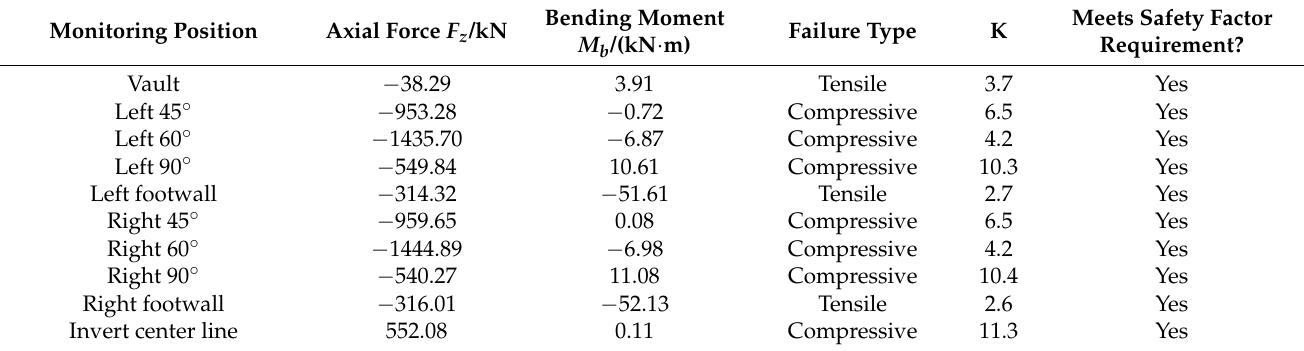
Table 5. Safety factor of each position after collapse